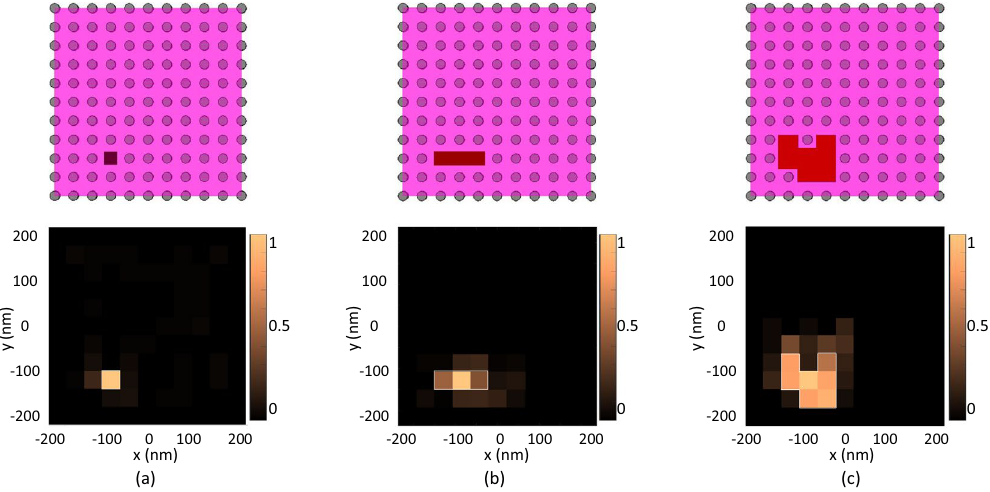
Figure 6. Input medium (top) and result of (bottom) imaging of diffusive material inside tissue at three steps with different shapes and material with a refractive index of ( a ) 1.5, ( b ) 1.4 and ( c ) 1.2 times the tissue.